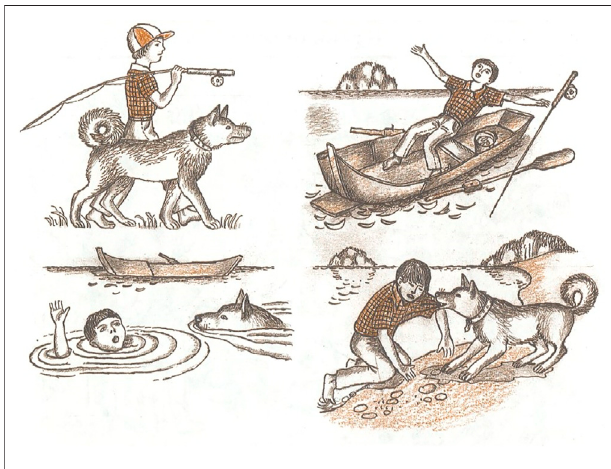
FIGURE 2 | Picture stimulus for Dog story